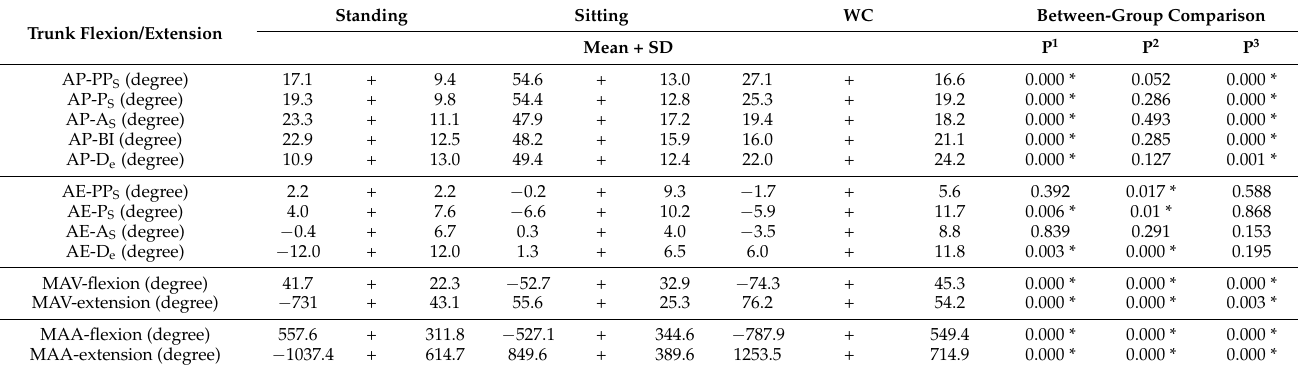
Table 5. Comparison of trunk flexion/extension position, angular excursion, maximum angular velocity, and maximum angular acceleration of three different